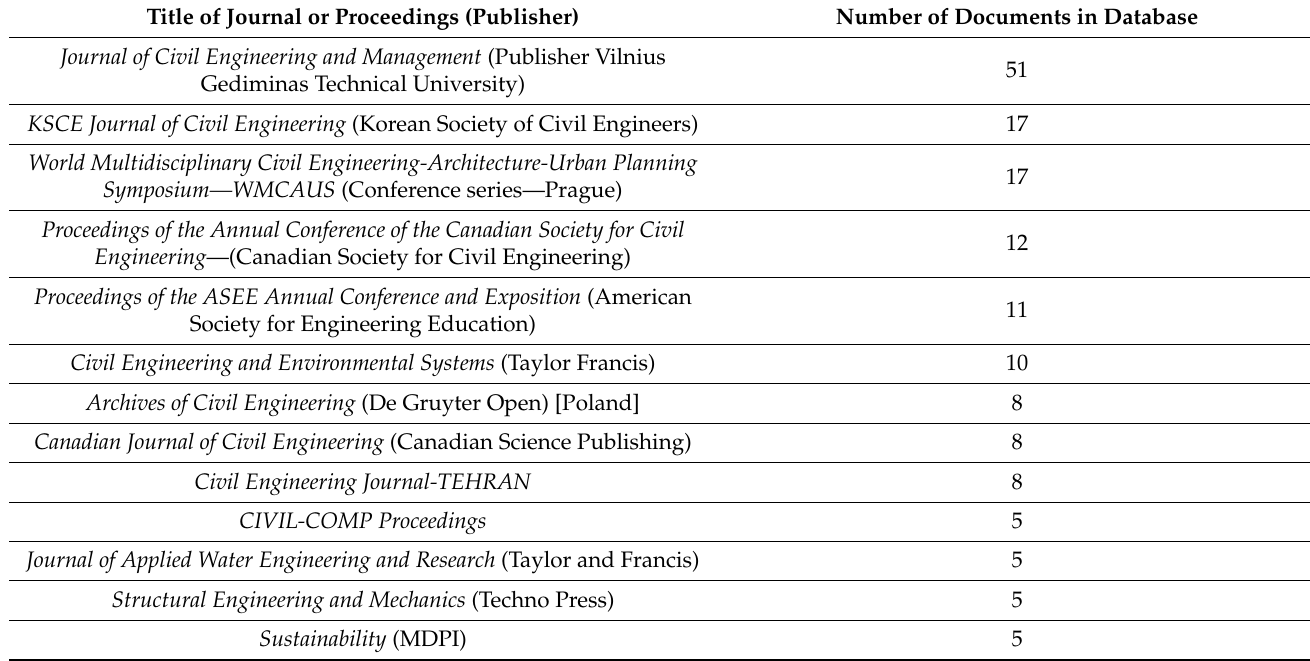
Table 4. Journals ranked by number of papers in broad search database (publisher in